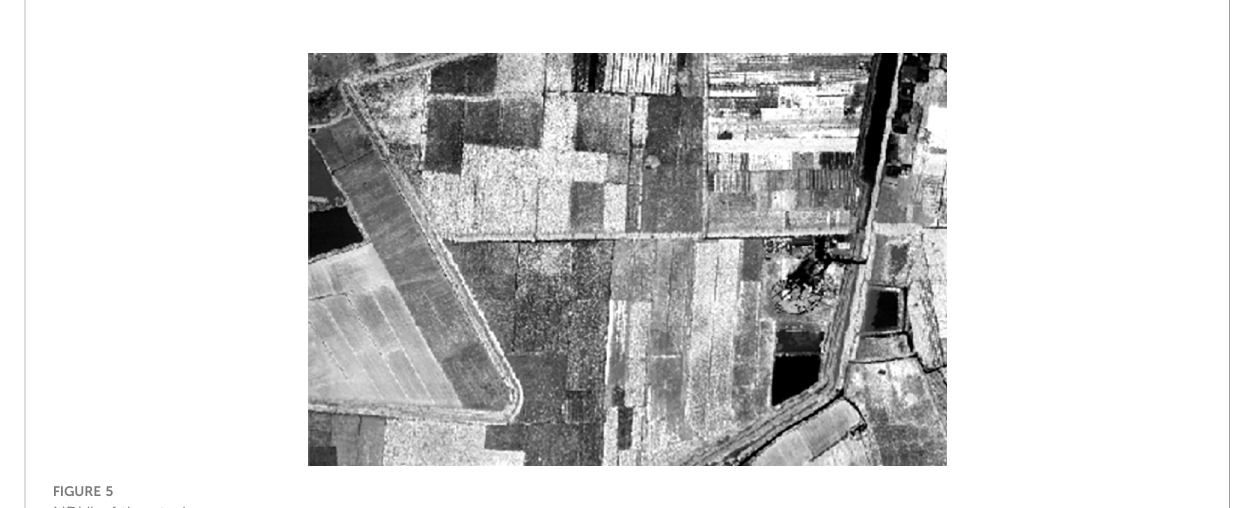
FIGURE 5 NDVI of the study